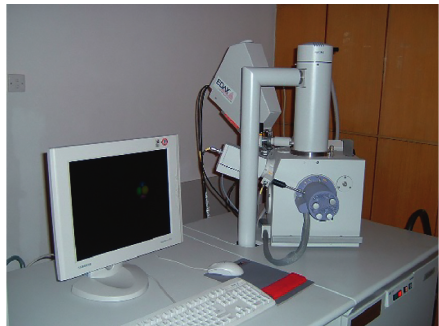
Figure 6: Sem (Hitachi limited, S–3000N).